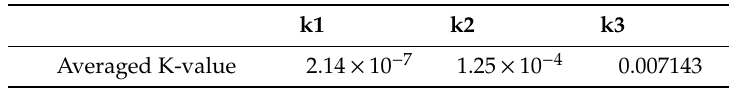
Figure 5. comparison result between the estimated and experimental results for the ECBE model verification for each cell after the completion of the test (Cell A1, A2 are tested for 500 cycles, A3, A4 are tested for 550 cycles, A5, A6 are tested for 600 cycles, and A7, A8 are tested for 650 cycles).